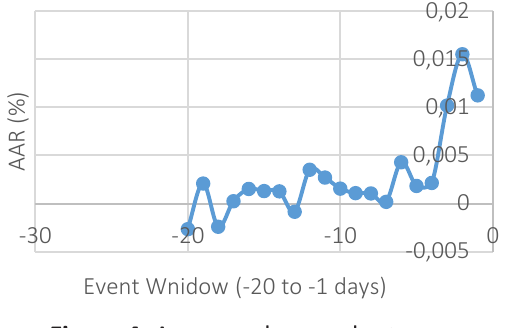
Figure 4. Average abnormal returns for the period of (–20, –1) days